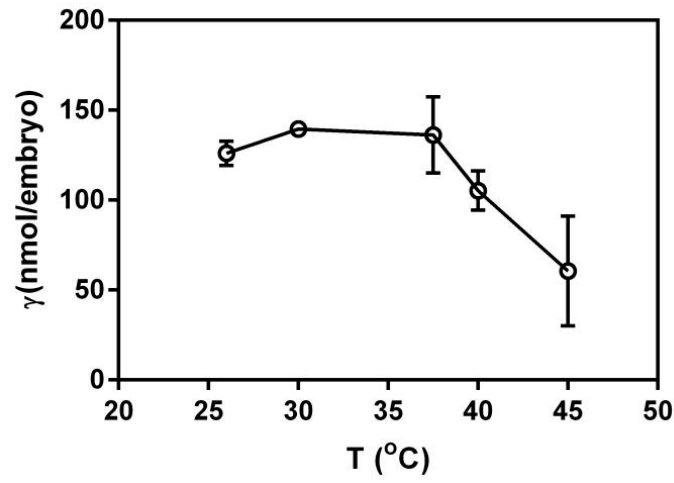
Figure 3. Effects of temperature on g of PFLX (1.00 mM) on embryos ( n = 5).